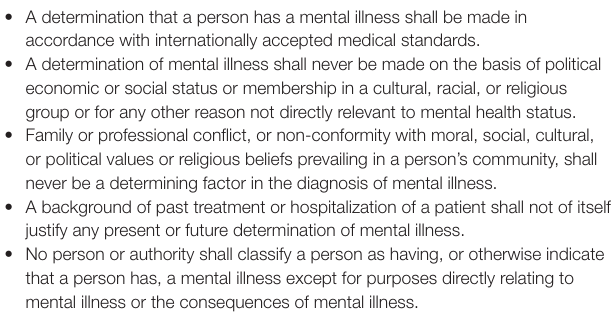
TABLe 1 | Principles for the protection of persons with mental illness and for the improvement of mental health care (Un,